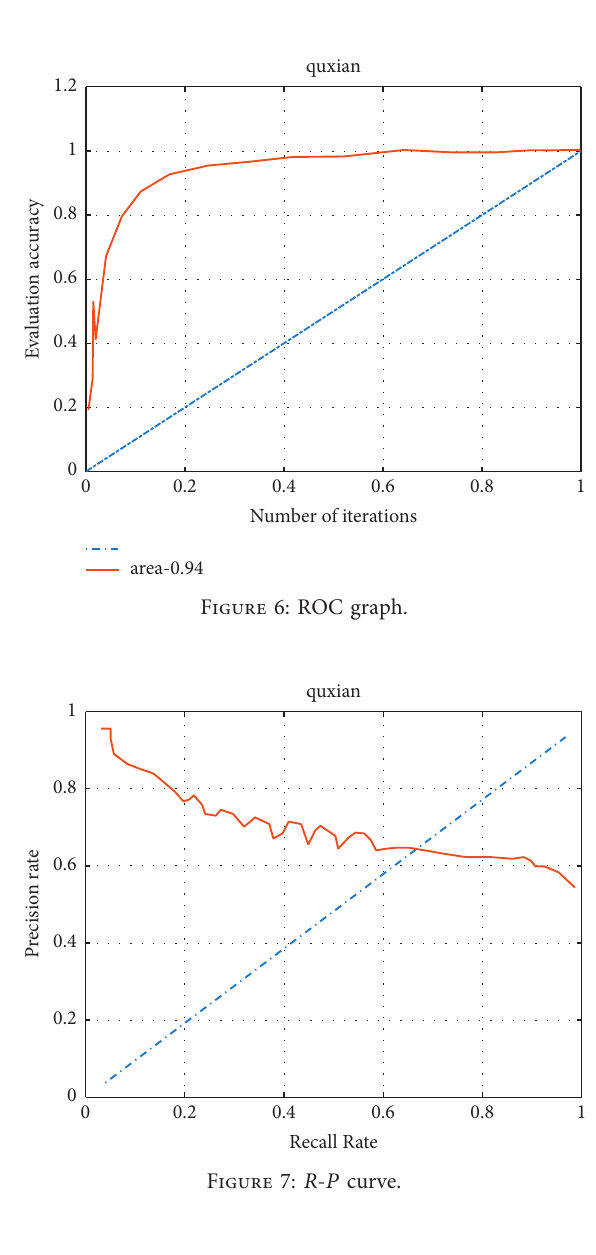
Figure 7: R - P curve.